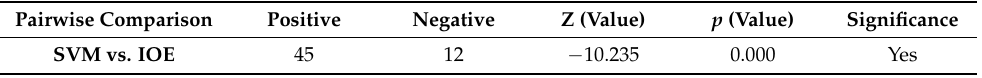
Table 7. Performance of the two landslide susceptibility models using the Wilcoxon signed-rank test. Pairwise Comparison The standard p -value is